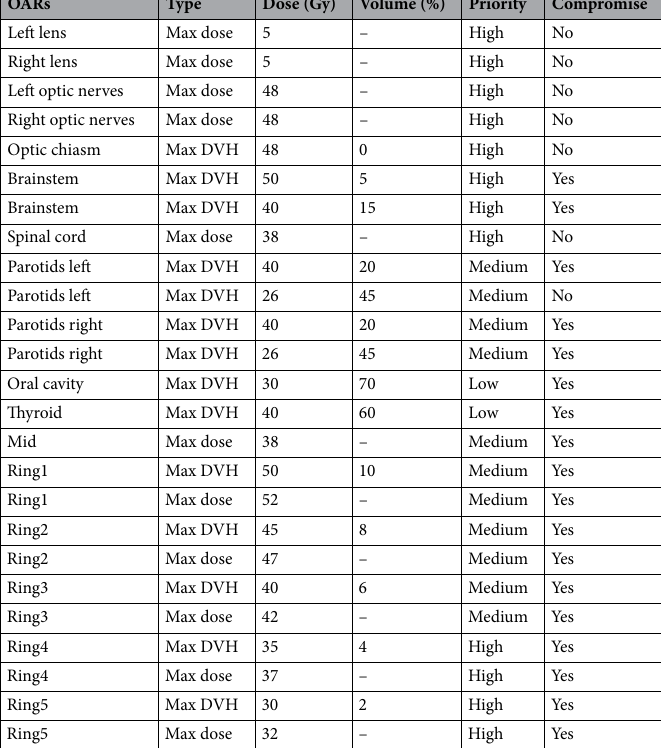
Table 3. OARs optimization goals in treatment